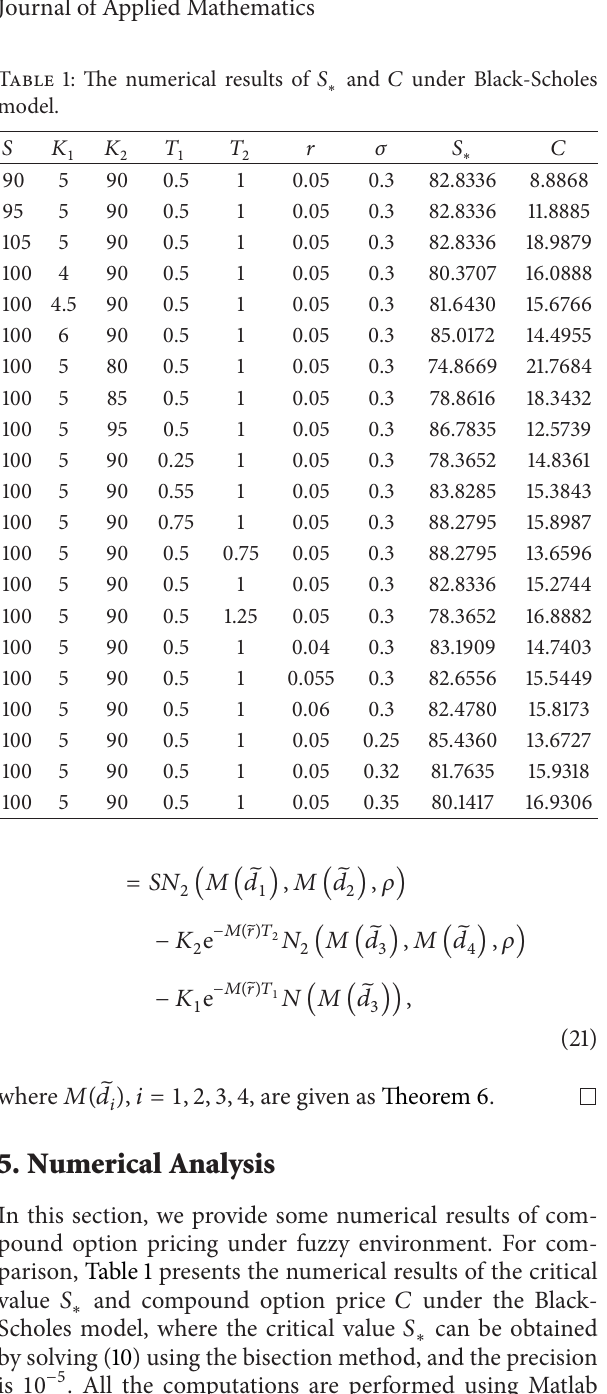
Table 2: The numerical result of 𝑆 ∗ and